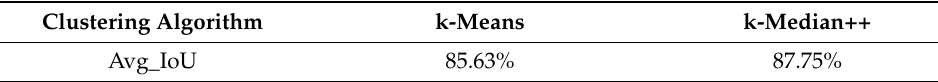
Table 3. Clustering